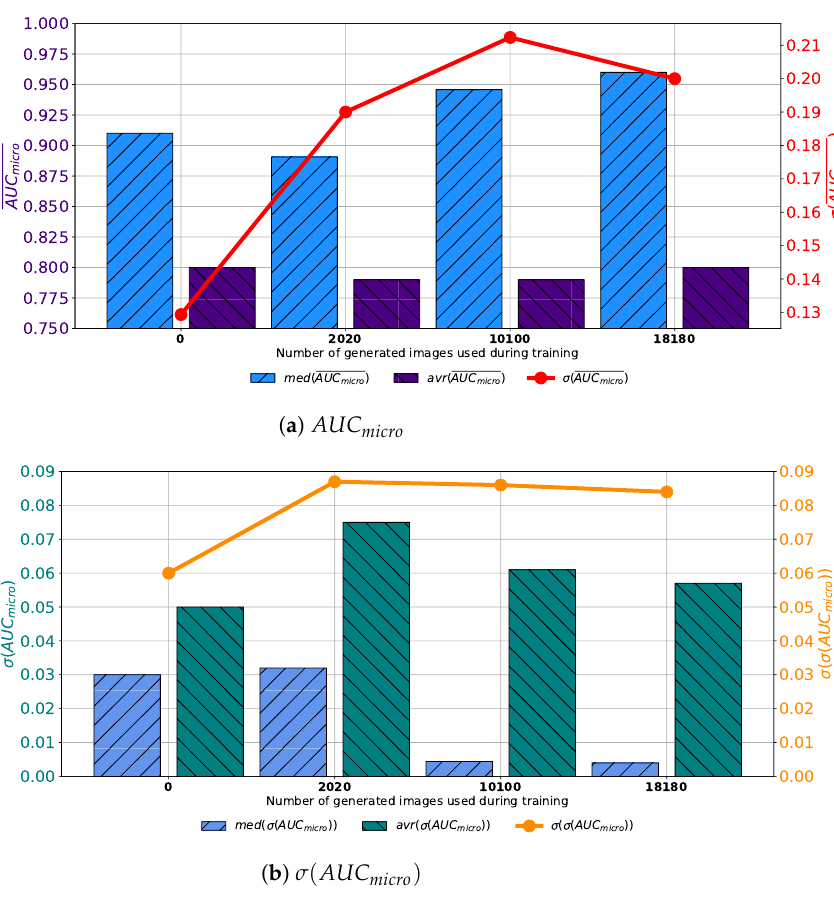
Figure 12. Median, average AUC micro and standard deviation of AUC micro and σ ( AUC micro ) for the case of VGG-16 trained with images generated by GAN in 250